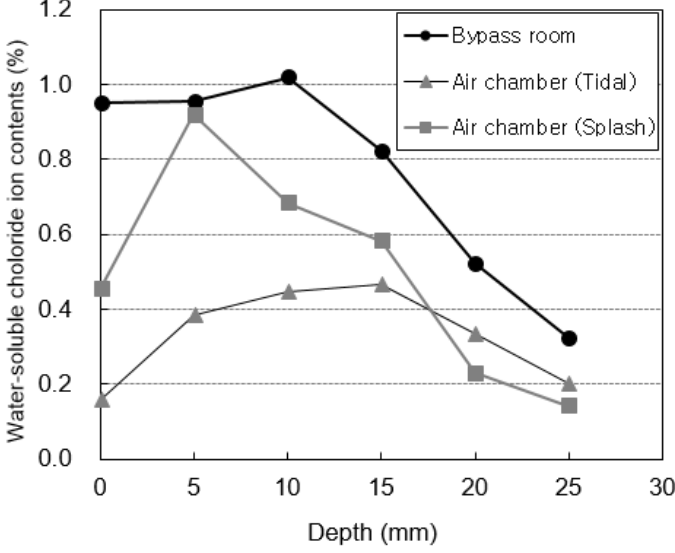
Figure 8. Chloride-ion content under pressure.